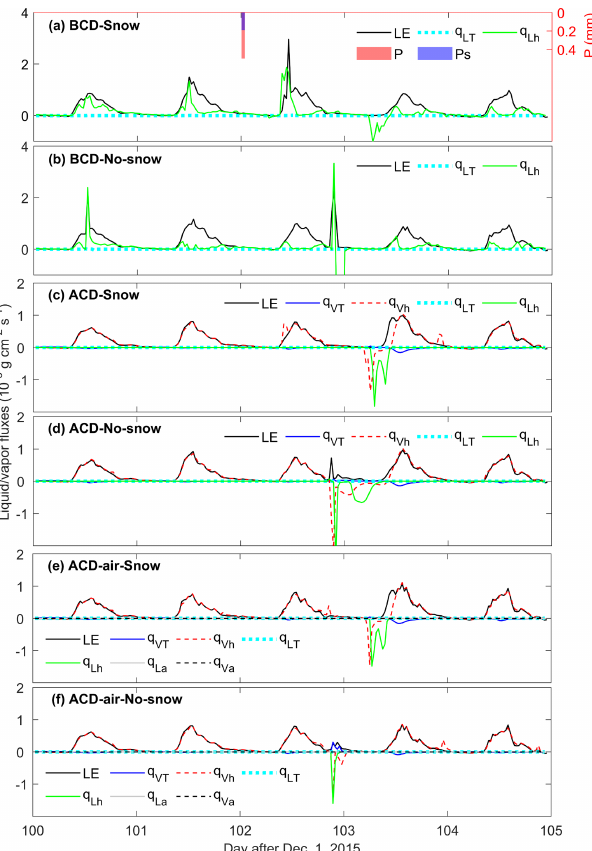
Figure 9. Model-simulated latent heat flux and surface soil (0.1cm) thermal and isothermal liquid water and vapor fluxes ( LE , q VT , q Vh , q LT , q Lh , q La , q Va ) using BCD (a, b) , ACD (c, d) , and ACD-air (e, f) simulations with and without the snow module, respectively, dur- ing the typical 5d thawing periods (from the 100th to 104th day after 1 December 2015). Panel (a) , (c) , and (e) are the surface soil thermal and isothermal liquid water and vapor fluxes simulated by BCD-Snow, ACD-Snow, and ACD-air-Snow model, respectively. Panels (b) , (d) , and (f) are the surface soil thermal and isothermal liquid water and vapor fluxes simulated by BCD-No-Snow, ACD- No-Snow, and ACD-air-No-Snow model, respectively. LE is the la- tent heat flux, q VT and q Vh are the water vapor fluxes driven by tem- perature and matric potential gradients, respectively, q LT and q Lh are the liquid water fluxes driven by temperature and matric poten- tial gradients, respectively, and q La and q Va are the liquid and vapor water fluxes driven by air pressure gradients, respectively. Positive and negative values indicate upward and downward fluxes, respec- tively. Note that the surface LE fluxes without snow sublimation are presented here. P is the precipitation, and Ps is the